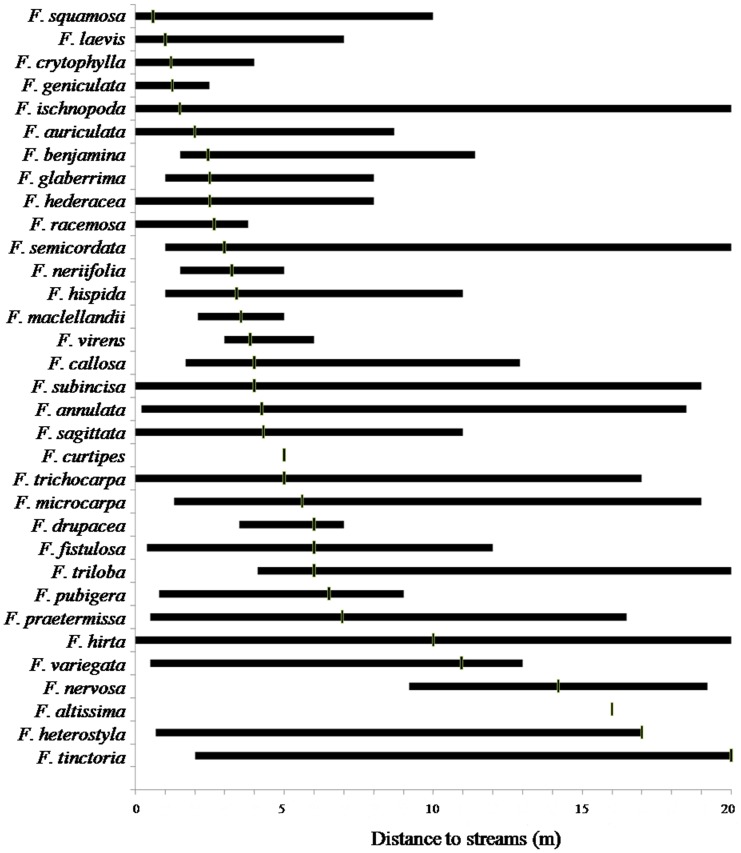
Median distance to streams (vertical solid lines) and ranges of occurrence of Ficus species (all four sites combined).See Table S2 in File S3 for number of stems of each species and where 75% of the total stems occur.